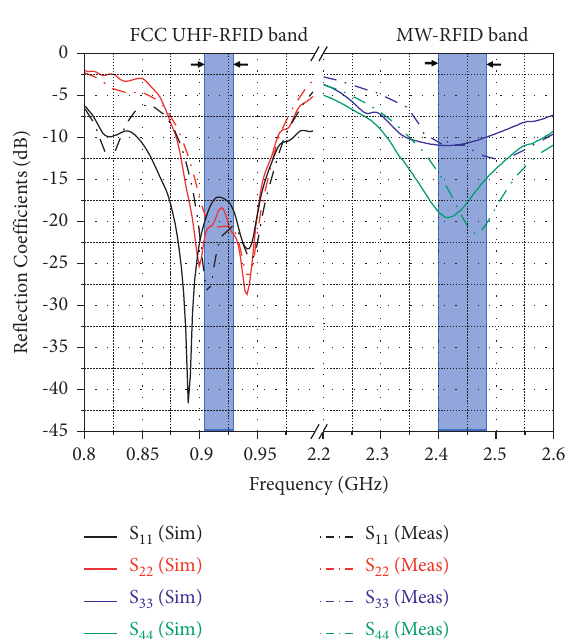
Figure 8: Simulated and measured reflection coefficients of the